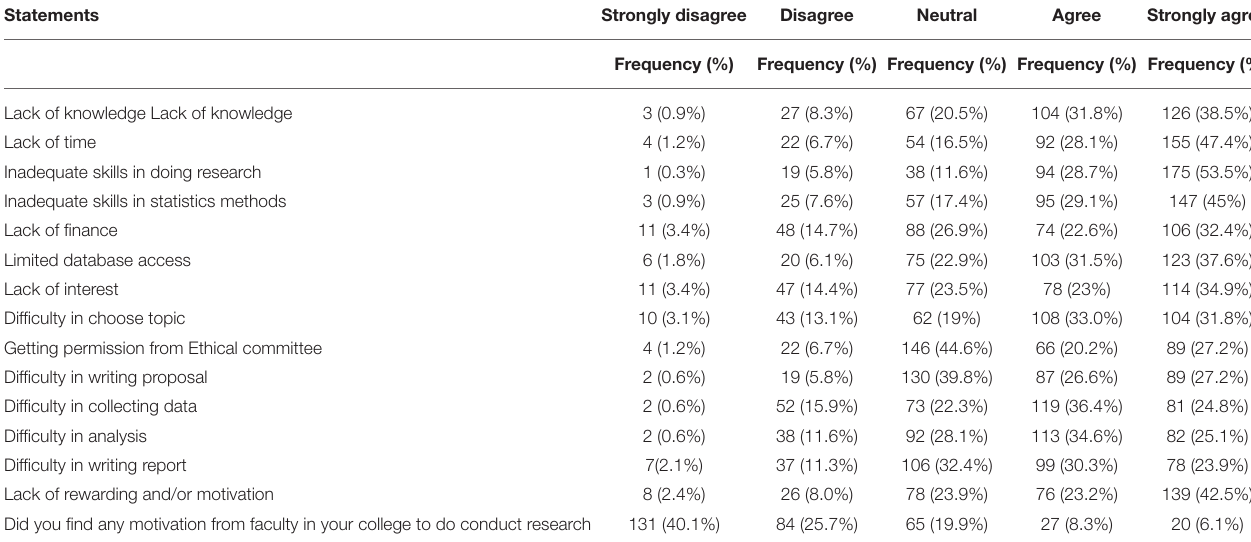
TABLE 3 | Barriers experienced by medical students in conducting research.